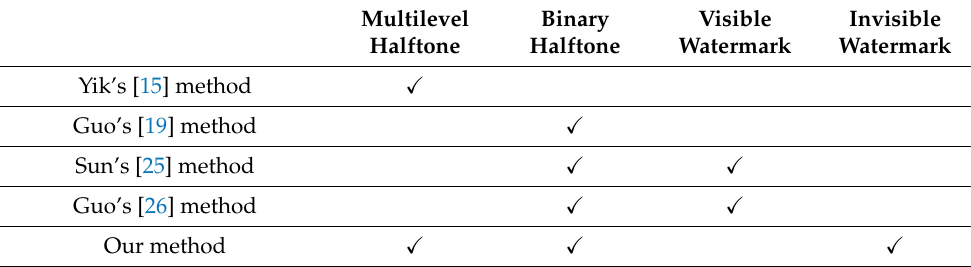
Table 2. A list of the relevant halftone